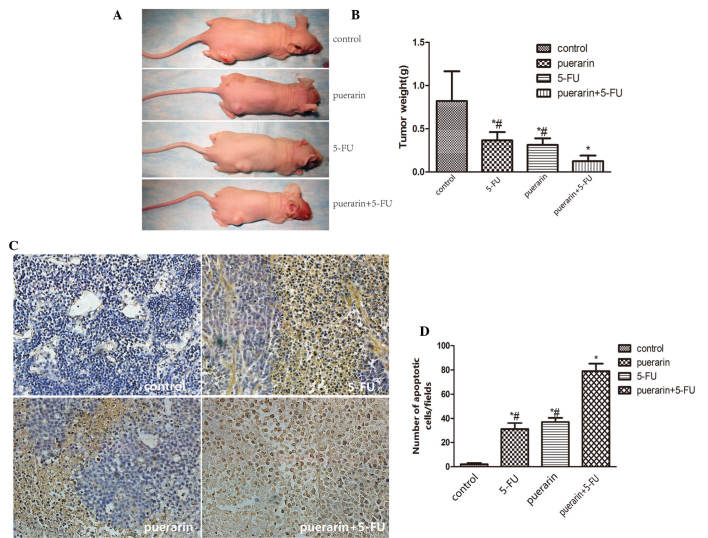
(A) Dimensions and (B) weight of tumors at the end of the experiment. (C) Apoptotic cells were detected in xenograft tumor tissue using the TUNEL assay. Apoptotic cells appear brown and are indicated by arrows. Magnification, ×200. (D) Quantified results of the TUNEL assay. Values are presented as the mean ± standard deviation (n=6 per group). *P<0.05, compared with the puerarin+5-FU group; #P<0.05, compared with the control group. 5-FU, 5-fluorouracil; TUNEL, terminal deoxynucleotidyl transferase dUTP nick end labeling.